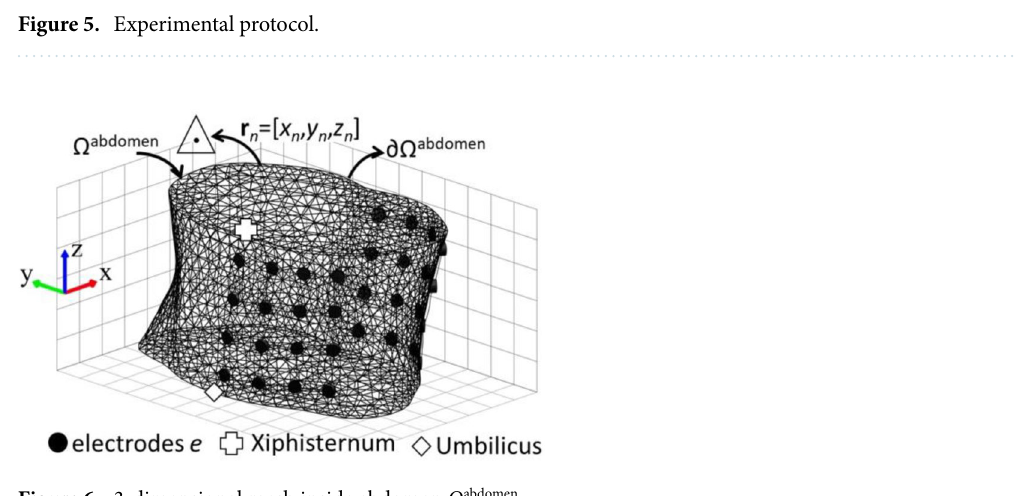
Figure 6. 3-dimensional mesh inside abdomen Ω abdomen